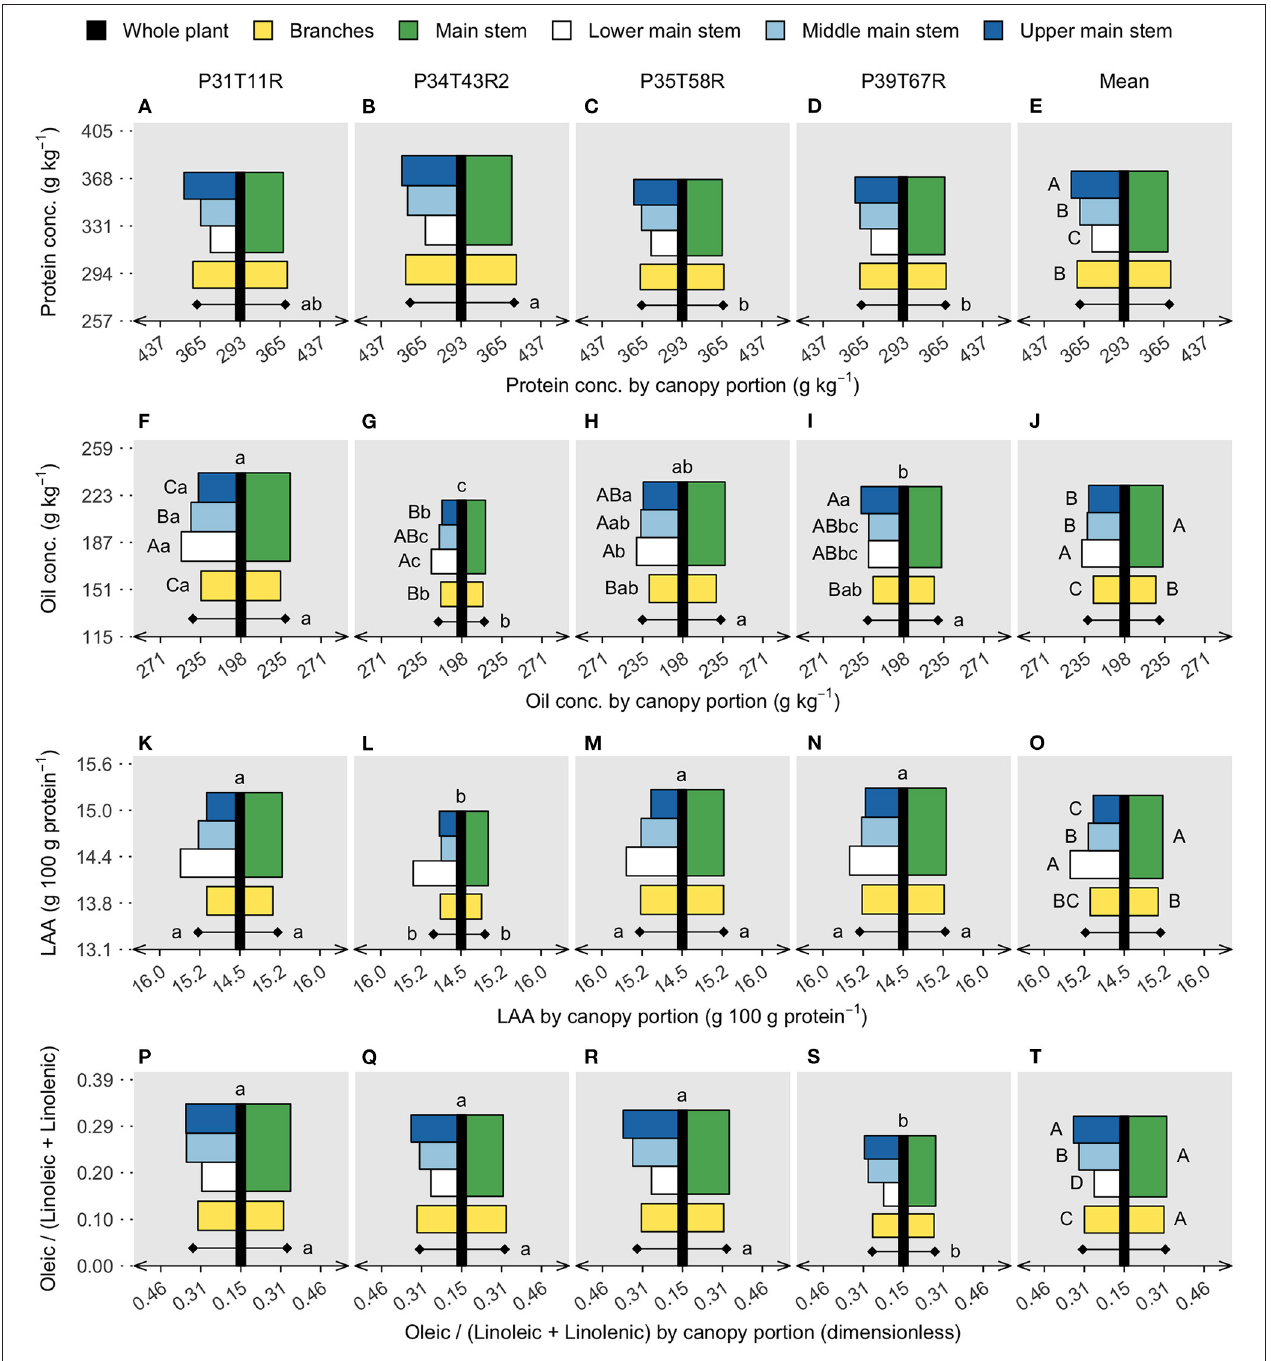
FIGURE 3 | Soybean seed protein (A–E) and oil concentration (F–J) , limiting amino acids (LAAs) abundance (K–O) , and oleic/(linoleic + linolenic) ratio (P–T) . Vertical black bars refer to the whole plant data, in the y axis, with lowercase letters comparing genotypes. Horizontal bars are centered on the black bar (x axis), referring to two canopy portions on the right side (main stem and branches) and four canopy portions on the left side (lower, middle, and upper main stem segments and branches). Diamonds represent canopy portion means on each side. Uppercase letters compare canopy portions within genotype (significant interaction) or on the overall mean (canopy portions single effect). Lowercase letters compare genotypes within canopy portions (interaction) or on the genotype mean, diamonds (genotype single effect). The absence of letters represents no significant difference in the analysis of variance ( p < 0.05).